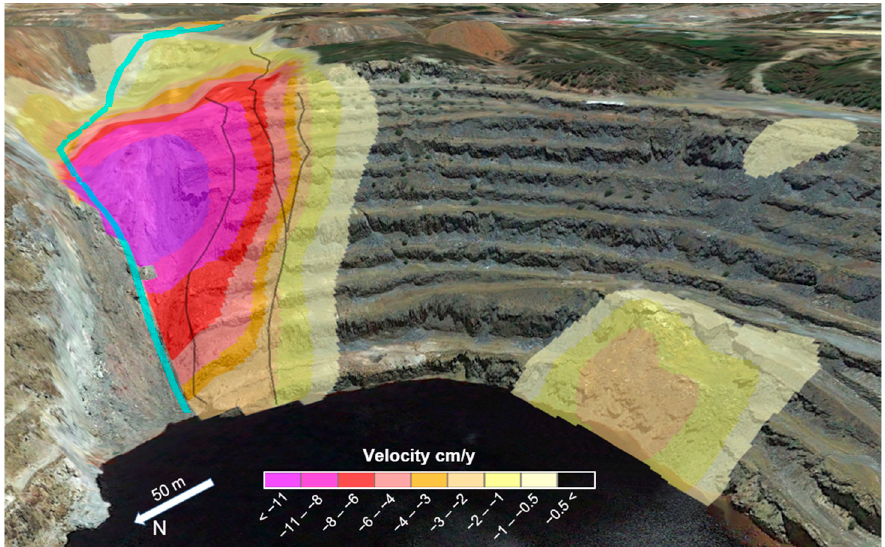
Figure 13. Zoom in the surface deformation map on the Atalaya pit. The block slide seems to be limited by the fracture zone (black lines) and the contact of the massive sulfides with the siliciclastic sediments of the Culm Group (thick blue line). Apart from the major displacements in the eastern wall, other minor displacements in the south wall seem related to debris slides of collapsed terraces.